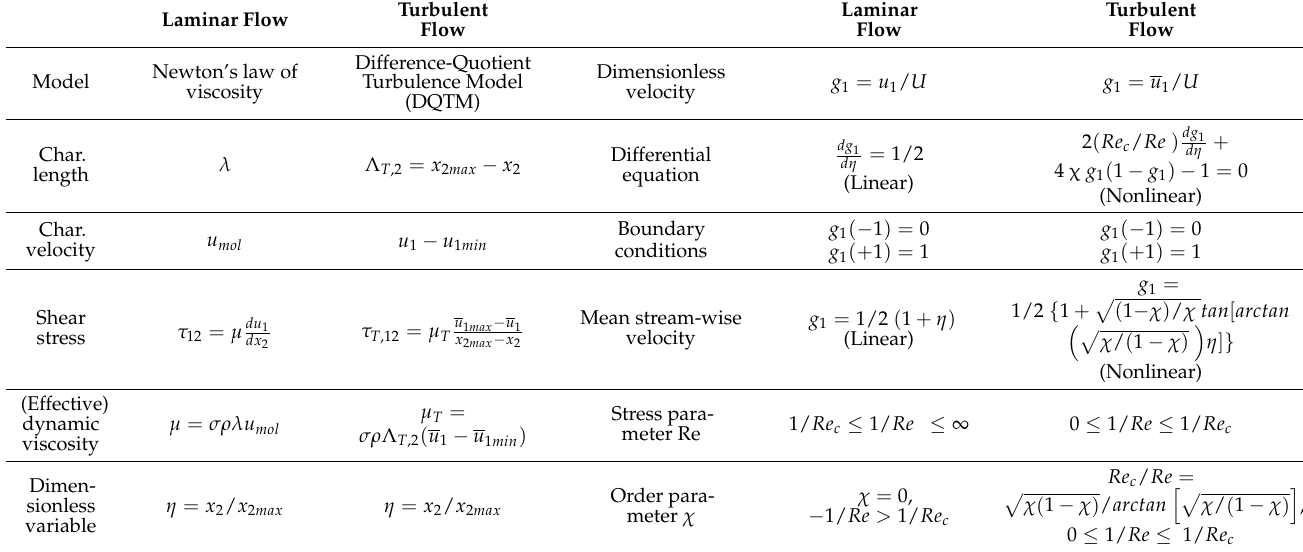
Table 1. Analogies between laminar and turbulent flow constitutive equations and their solutions for plane laminar and turbulent shear Couette